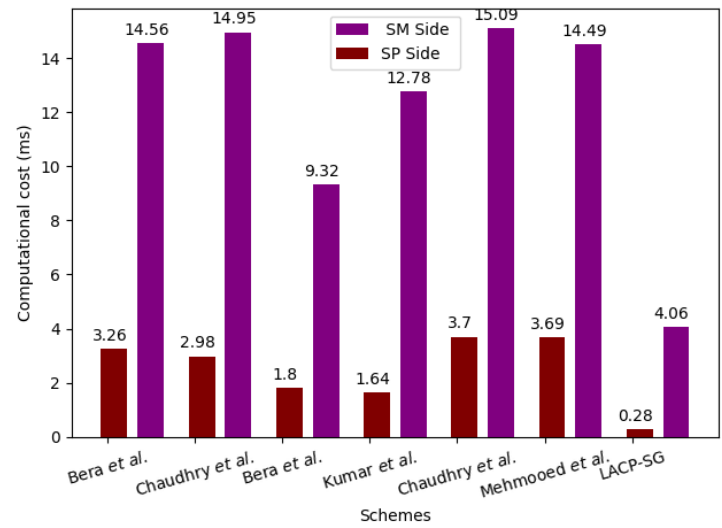
Figure 6. Computational cost at SM i and SP k side [11,20,29,30,34,35].